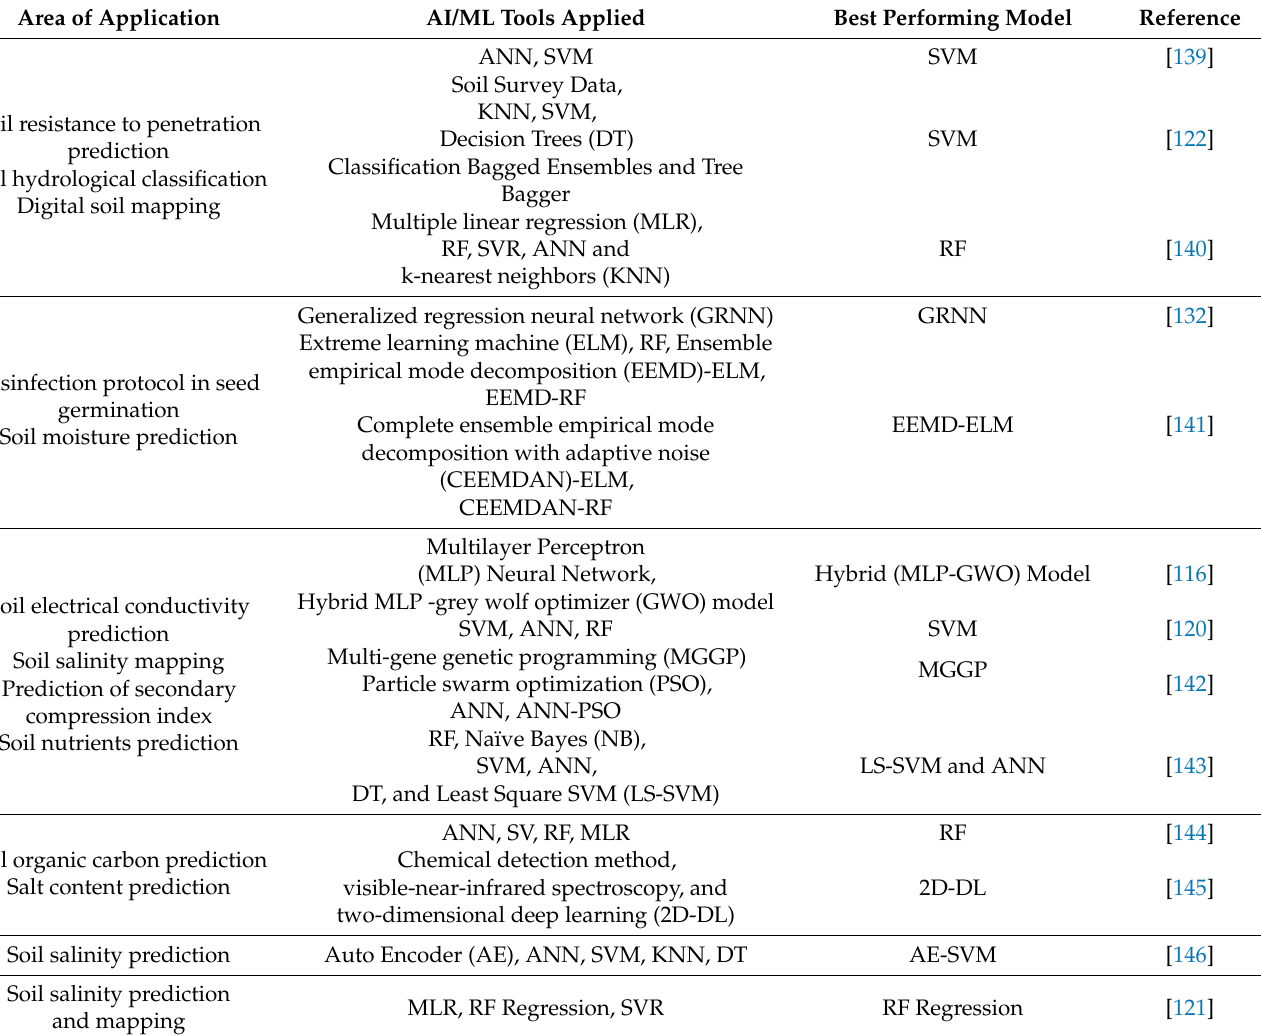
Table 2. Performance of AI and/or ML models in selected